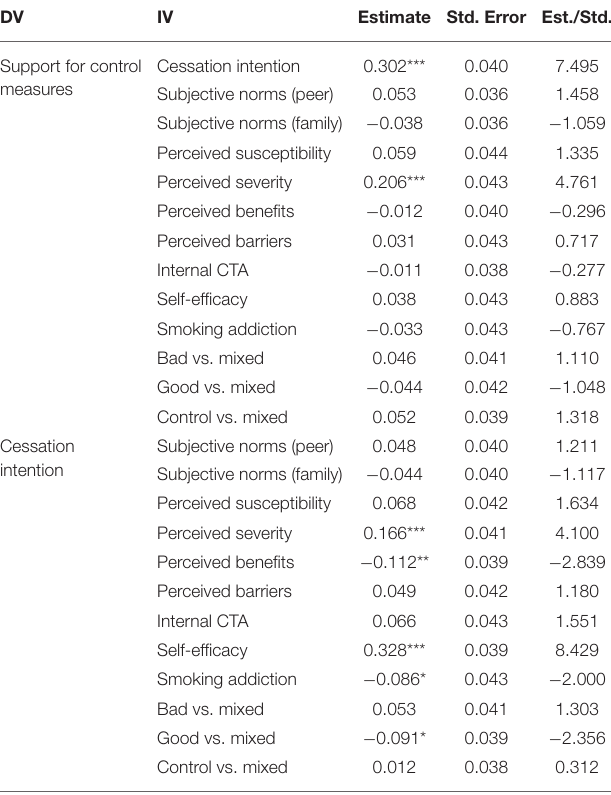
TABLE 2 | Results of model